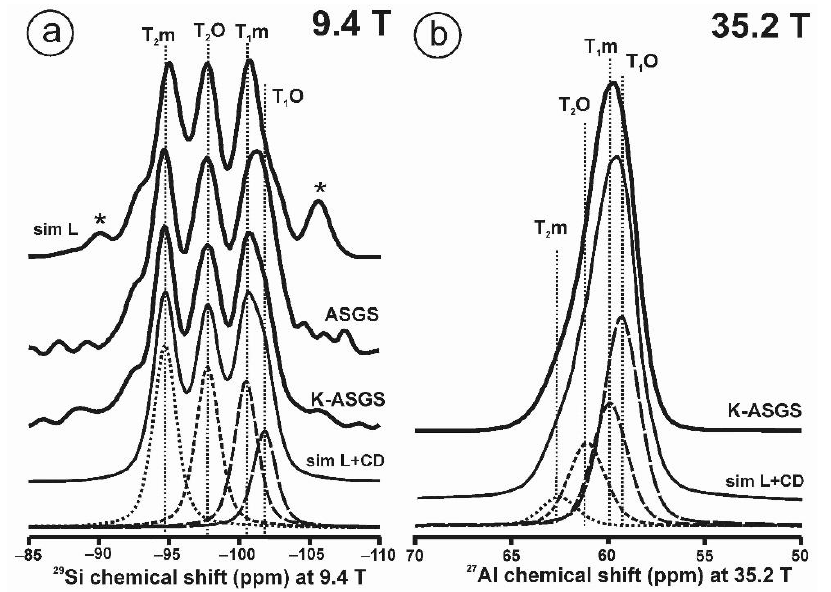
Figure 15. ( a ) The 29 Si MAS NMR spectra at 9.4 T of specimens ASGS and K-ASGS with two simulations, sim L (Loewenstein restriction) and sim L+CD when additional charge dispersion (CD) is also considered, with four signals from the tour T sites in the C 1̅ space-group symmetry. The resonances of the simulation that do not appear in the experimental spectra are indicated by *. ( b ) The 27 Al spectrum of specimen K-ASGS and the simulated spectrum using the same restrictions as in the 29 Si spectrum (see explanation in text). The four Voigt curves for xG/(1 − x)L = 0.7 correspond to the four T sites of the C 1̅ space-group symmetry. The experimental procedure for the 27 Al spectrum at 35.2 T is as in Figure 1; for the 29 Si spectrum is as in ref [4].